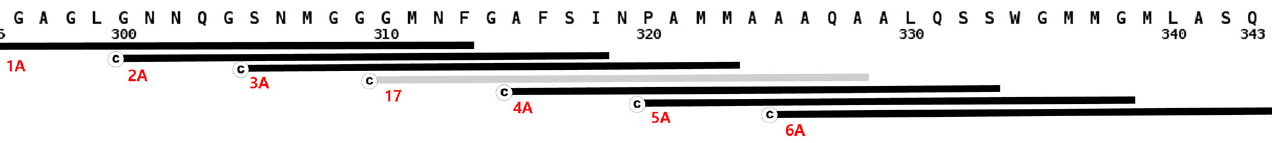
Figure 8. Design of overlapping TDP-43 peptides relative to the region of interest (aa 310–329). Only peptides 1A, 3A, and 4A were successfully synthesized.